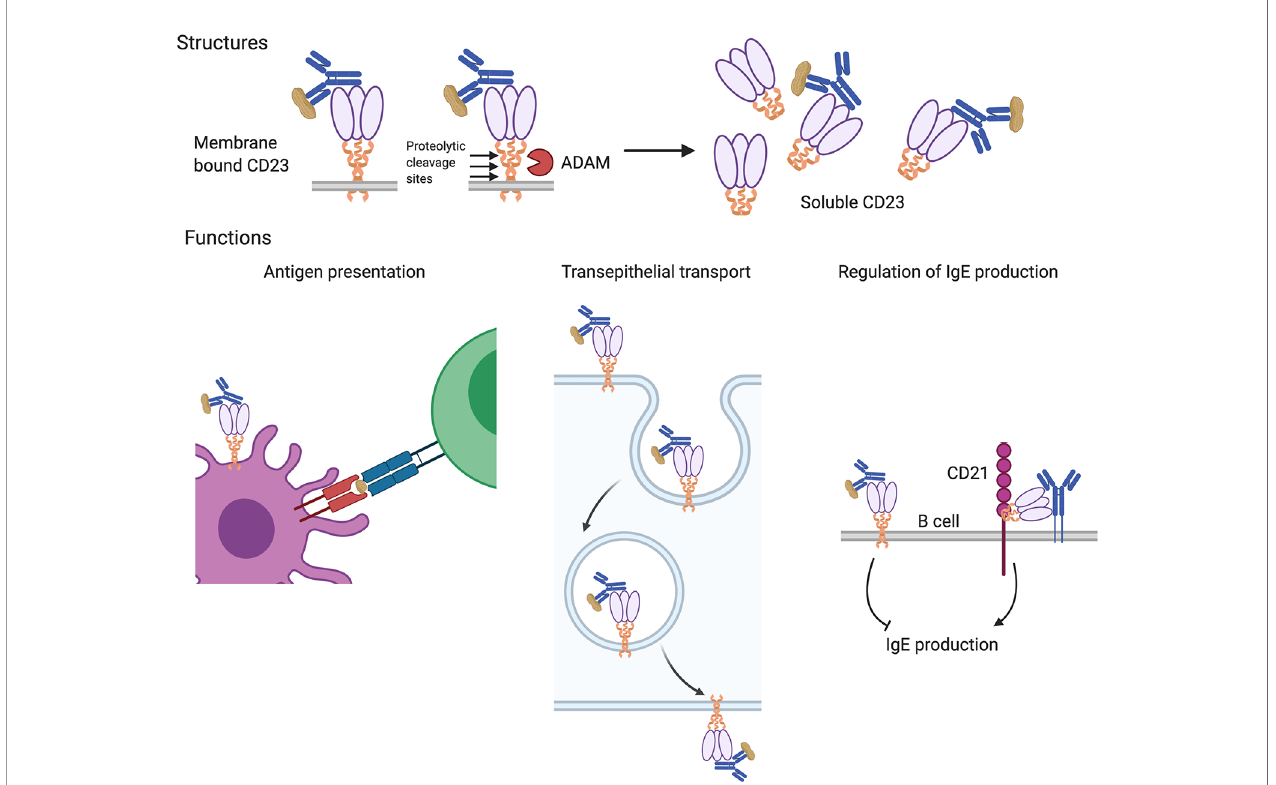
FIGURE 2 | Structures and functions of the low-af fi nity IgE receptor, CD23. CD23 is expressed as a multimer of subunits consisting of coiled-coil stalks with lectin- family domain heads that bind to IgE (upper panels). Membrane-bound CD23 can be converted to a soluble form that retains IgE-binding ability following cleavage at protease sites by endogenous (ADAM) or allergen (e.g. Der p 1 ) proteases. Various functions have been attributed to CD23 (lower panels). It can facilitate antigen uptake for presentation by B cells and antigen presenting cells to T cells (left panel) and mediate the transport of allergens across polarized epithelium in the gut and airway (center panel). CD23 also regulates IgE production; the transmembrane form on B cells suppresses their production of IgE and the soluble form, via interactions with B cell surface CD21 and IgE, enhances IgE production (right